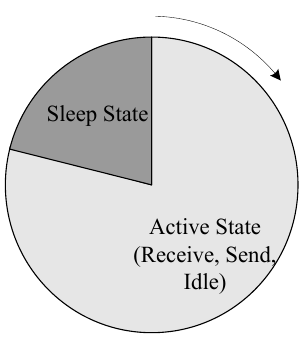
Figure 1. Work cycle of a node.